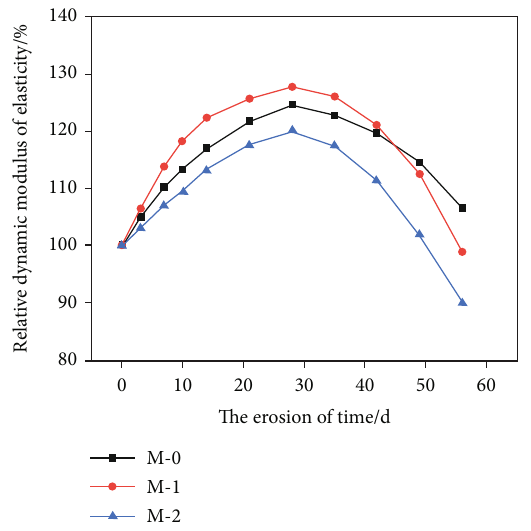
Figure 3: Variation curve of relative dynamic elastic modulus of steel slag concrete with erosion time.